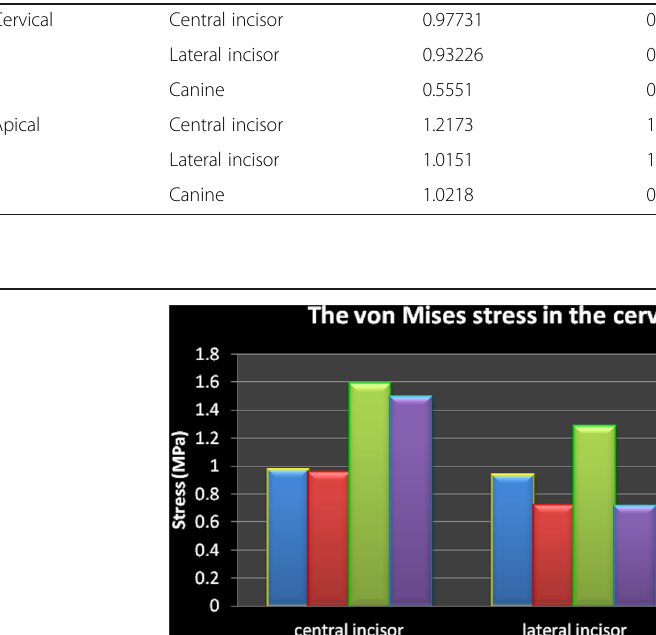
Fig. 9 The von Mises stress in the cervical area of the